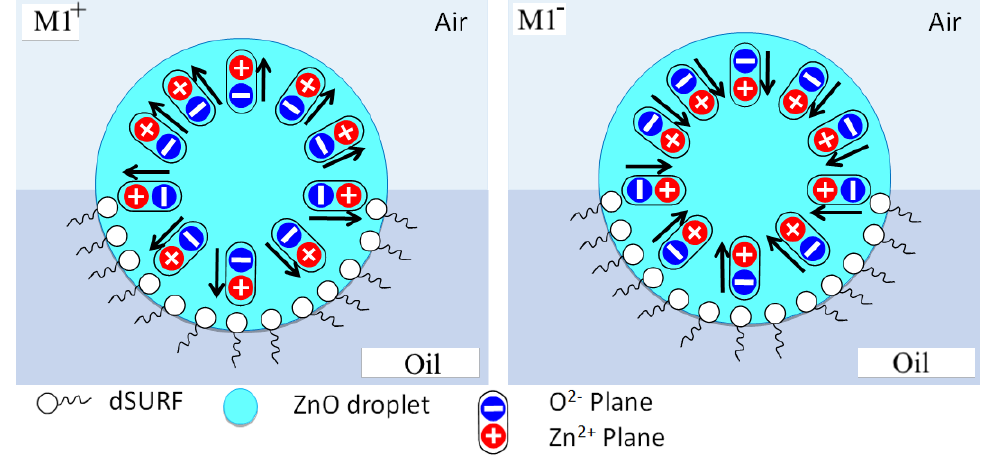
Figure 8. Schematic illustration of ZnO NP organizations leading to positively charged droplets (M1 + , left ) and negatively charged droplets (M1 − , right ) charged droplets, respectively. The coexis- tence of both organizations is mandatory to explain the observed square lattice of droplets.